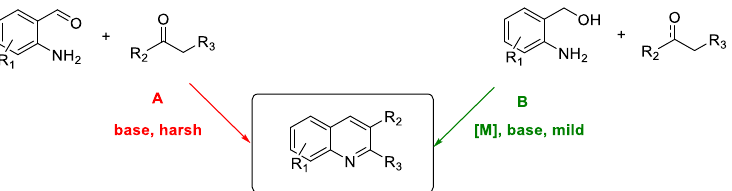
Figure 3. Friedländer classical condensation ( A ) and metal-catalyzed Friedländer condensation ( B ).